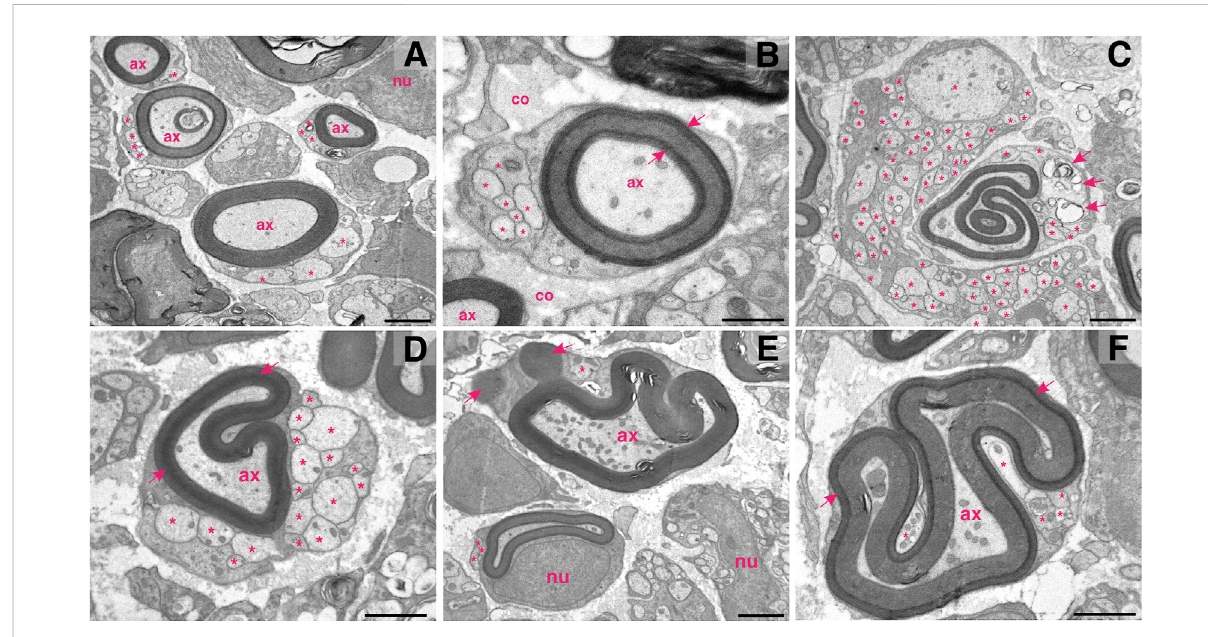
FIGURE 4 Schwann cells multitasking at the proximal stump of the injured femoral nerve. (A) In the fi eld of view: four myelinating Schwann harbouring well – preservedmyelinlamellae aroundtheinjuredaxons(ax)and atthesametimeaccommodating axonalsprouts (asterisks). (B) Thenewly formed myelin around theinjuredaxons can vary inits compactness (arrows indicate densely formed lamellae); co — collagen; nu — nucleus. (C) Hyperplastic cells: a giant non-myelinating Schwann cells abundant in sprouts (asterisks) adjoining a myelinating Schwann cell. Note that the myelinating Schwann cell contains two separated myelinated axons (one of a remarkable irregularity), a few cytoplasmic sprouts (asterisks) and proteolytic vesicles (arrows). (D) While re – shaping the myelin structure and compactness (arrows) around the injured axon (ax), a myelinating Schwann cell can concomitantlyhostmorethan10axonalsprouts(asterisks). (E) ASchwanncellsheddingmyelin(arrows)whilestillpreservingtheaxon(ax)andatthe same time carrying a sprout (asterisk). Note the abundancy of mitochondria within the axon. In the vicinity: another myelinating and two